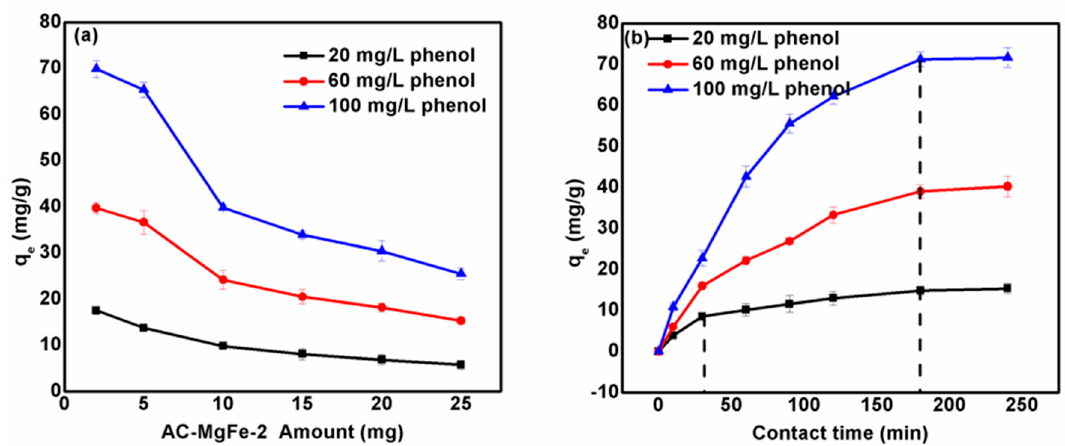
Figure 5. ( a ) Effect of dosage and ( b ) adsorption contact time on the sorption uptake of phenol by AC–MgFe-2 composite.